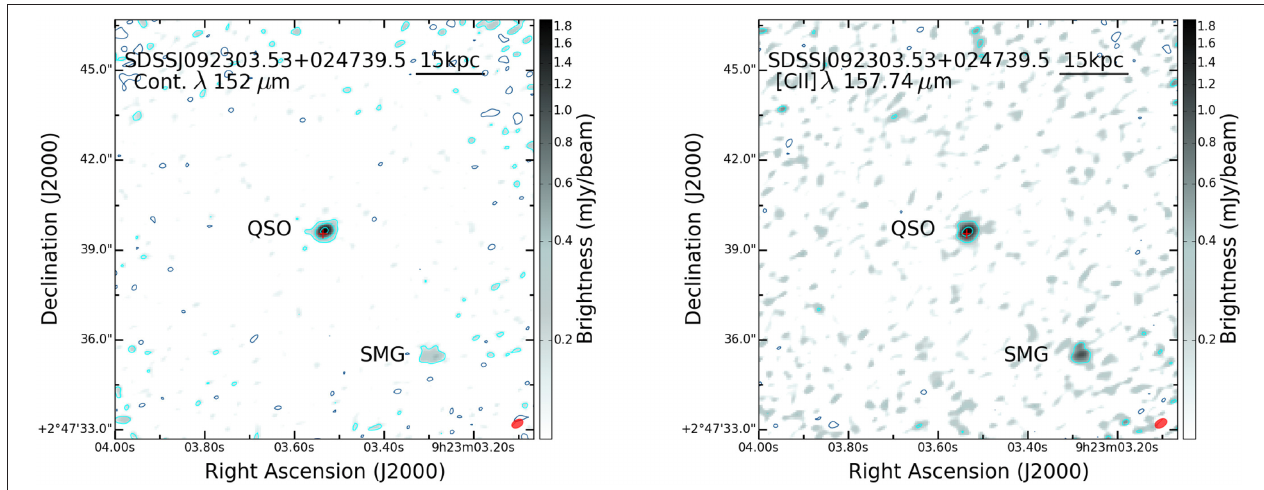
FIGURE 1 | Maps of the dust continuum (left) and [C II ] λ 157.74 µ m line (right) emission for one of the quasars in our sample, SDSS J092303.53 + 024739.5 at z QSO = 4.6589. Both the quasar host (marked as “QSO”) and a sub-mm companion galaxy (“SMG”) are robustly detected and marginally resolved (see the synthetized ALMA beam at the bottom right of each panel). The companion galaxy is separated by 36.5 kpc and 246 kms − 1 from the quasar host.